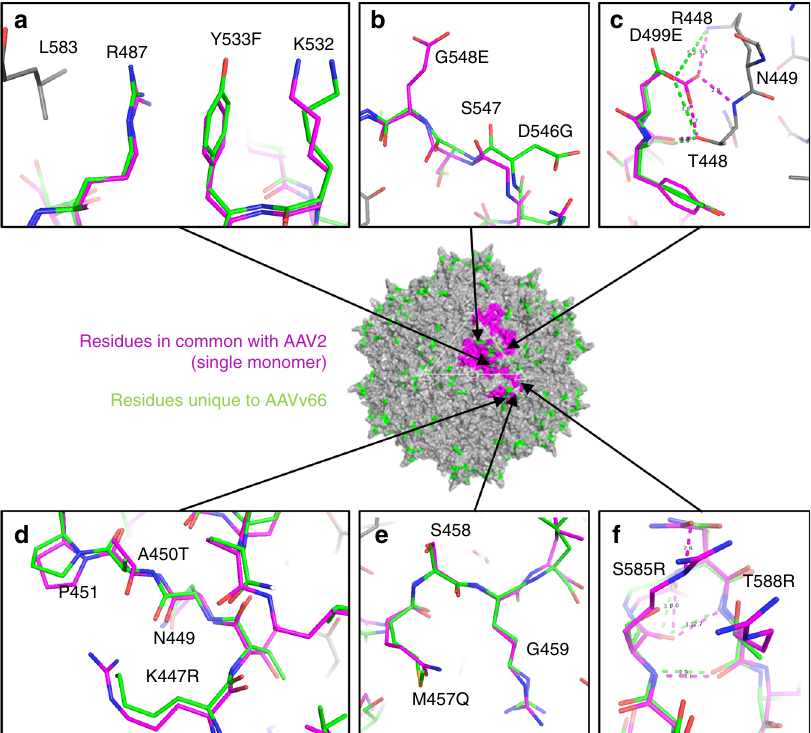
Fig. 6 Structural differences between AAVv66 and AAV2. At the center is the AAVv66 60-mer structure (grey). Amino acid residues unique to AAVv66 are highlighted in green, while amino acid residues for a single monomer that are in common with AAV2 are colored in magenta. a – e Atomic models showing residue side chains of select regions with substantial difference between AAVv66 and AAV2. The alignments were made using monomers of AAV2 (1lp3) and AAVv66, with modeled side chains from neighboring residues displayed in grey. Annotations for amino acids shown are indicated as those belonging to AAVv66, the position number, and then AAV2. c , f Distances between atoms of interest are indicated by dashed lines (AAV2, magenta; AAVv66, green) and reported in angstroms (Å). Distance measurements were conducted in PyMOL and are also reported in Supplementary Table